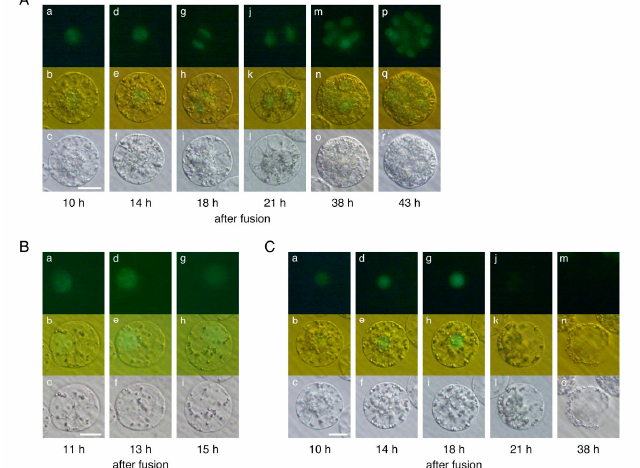
Figure 2. Developmental profiles of polyspermic rice zygotes after karyogamy. An egg cell was serially fused with two sperm cells expressing H2B-GFP, and the resulting zygote was analyzed. ( A ) After karyogamy, the polyspermic zygotes developed and divided into a two-celled embryo (a–l) and a globular-like embryo (m–r). ( B ) Developmental arrest of polyspermic zygotes (pattern I). Although the H2B-GFP signal was detectable in the zygotic nucleus, zygotes were highly vacuolated and became transparent (a–i) before they degenerated. ( C ) Developmental arrest of polyspermic zygotes (pattern II). The H2B-GFP signal was clearly detected in the zygotic nucleus during development (a–i); however, the fluorescent signal decreased and was undetectable at approximately 21 h after the fusion (j–l). The zygotes degenerated without dividing (m–o). Top, middle, and bottom panels represent fluorescent, merged fluorescent/bright-field, and bright-field images, respectively. Scale bars = 20 µ